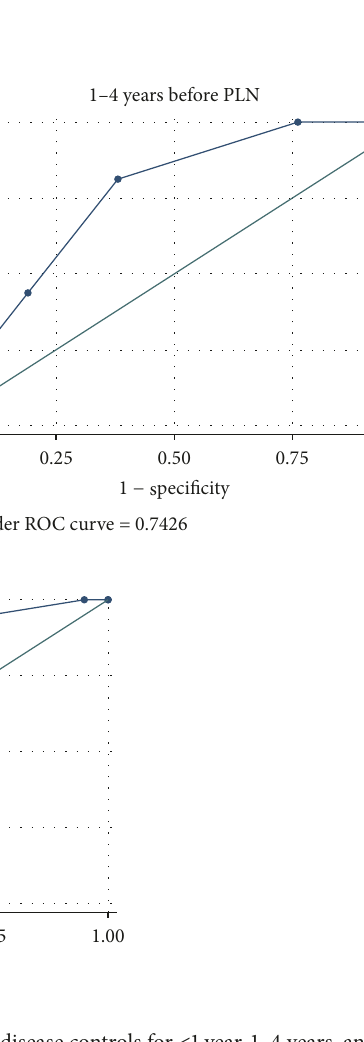
Figure 2: MPO-ANCA receiver operating curves for PLN cases versus SLE without LN disease controls for < 1 year, 1–4 years, and > 4 years before PLN